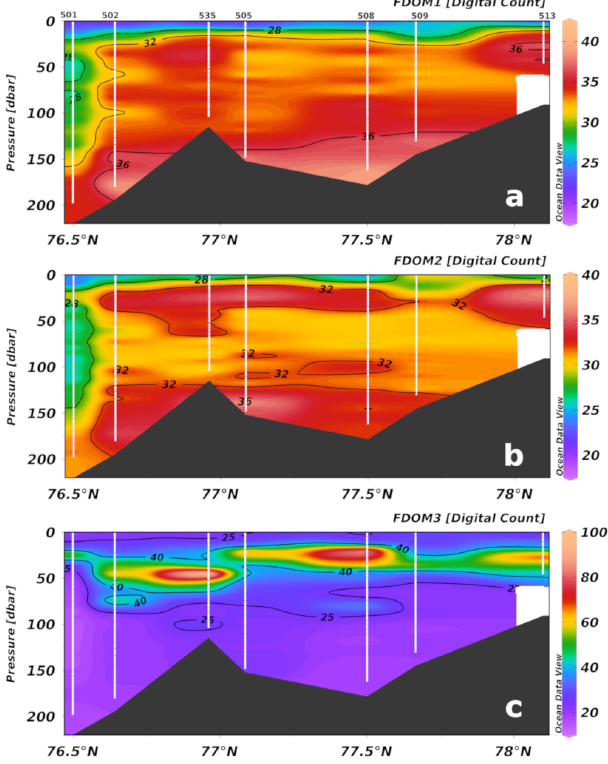
Figure 7. Section plots of FDOM (a) channel 1 (marine humic- like material), (b) channel 2 (terrestrial humic-like material), and (c) channel 3 (tryptophan-like material) from the in situ cast. Data locations shown with white dots. Plots are made with Ocean Data View (Schlitzer, Reiner, Ocean Data View, https://odv.awi.de/, last access: 30 January